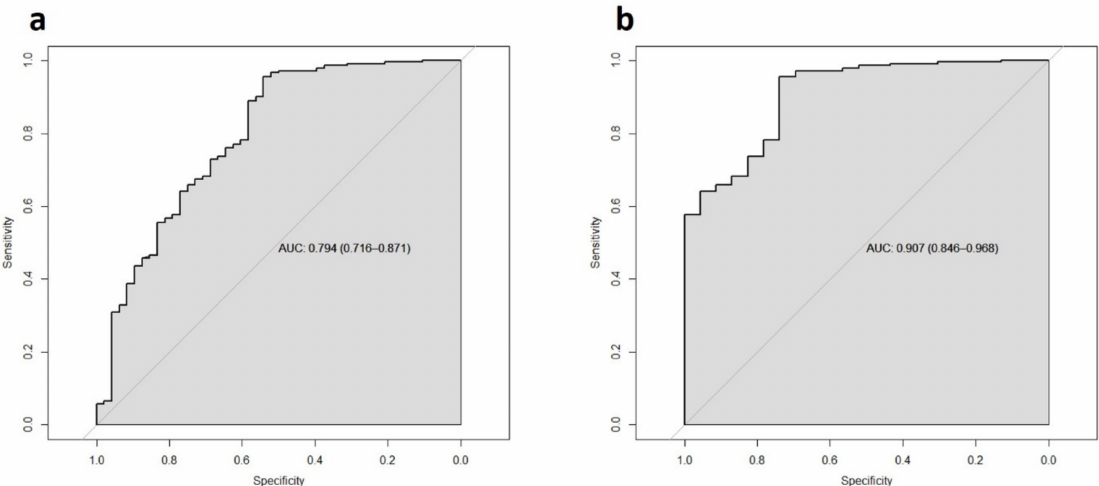
Figure 3. Receiver operating characteristic (ROC) curves for sensitivity (SE) and specificity (SP) of XBCM according to the reference definition follow-up total (FUT): tumor overall ( a ), high-grade tumor ( b ).